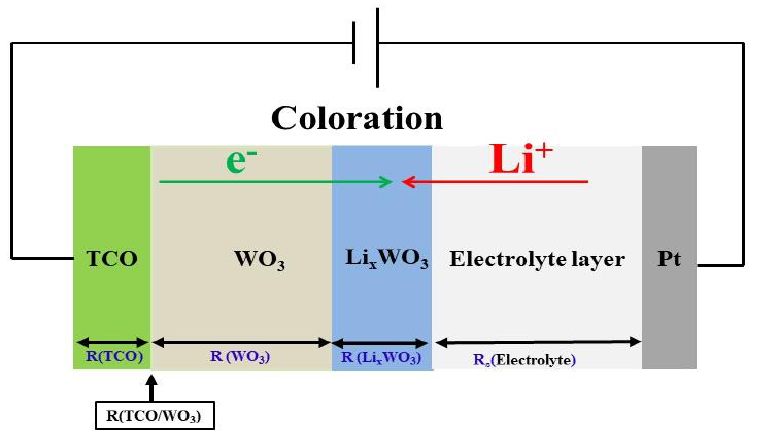
Figure 8. A schematic of the electrochemical reaction for WO 3 films in an electrolyte which is conductive by applying potential.